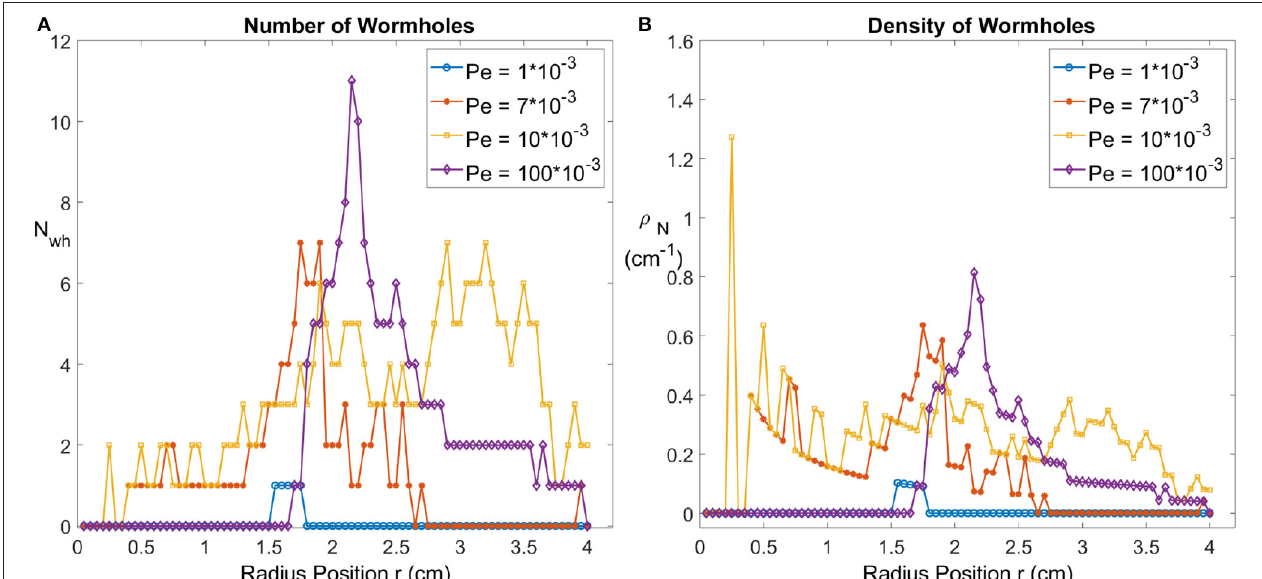
FIGURE 6 | (A) The number of wormholes N wh as a function of radius r, for four different Péclet numbers. (B) The density of wormholes ρ N as a function of radius r.